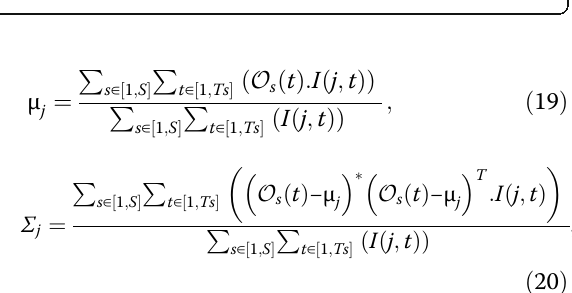
Fig. 4 Examples of key poses retained for the Catch an object